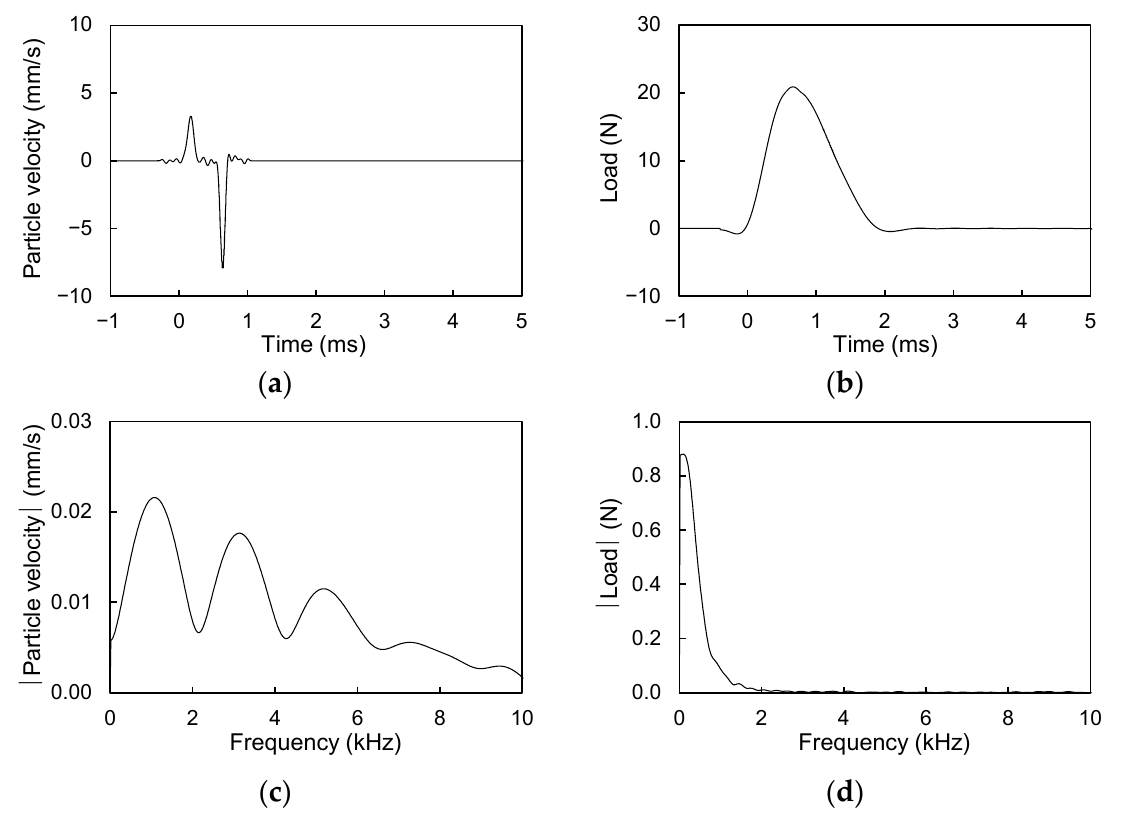
Figure 10. Load and particle velocity signals at measurement location of L = 0 mm for 15 mm thick acrylic plate: ( a ) particle velocity signal in time domain; ( b ) load signal in time domain; ( c ) particle velocity in frequency domain; and ( d ) load signal in frequency domain.